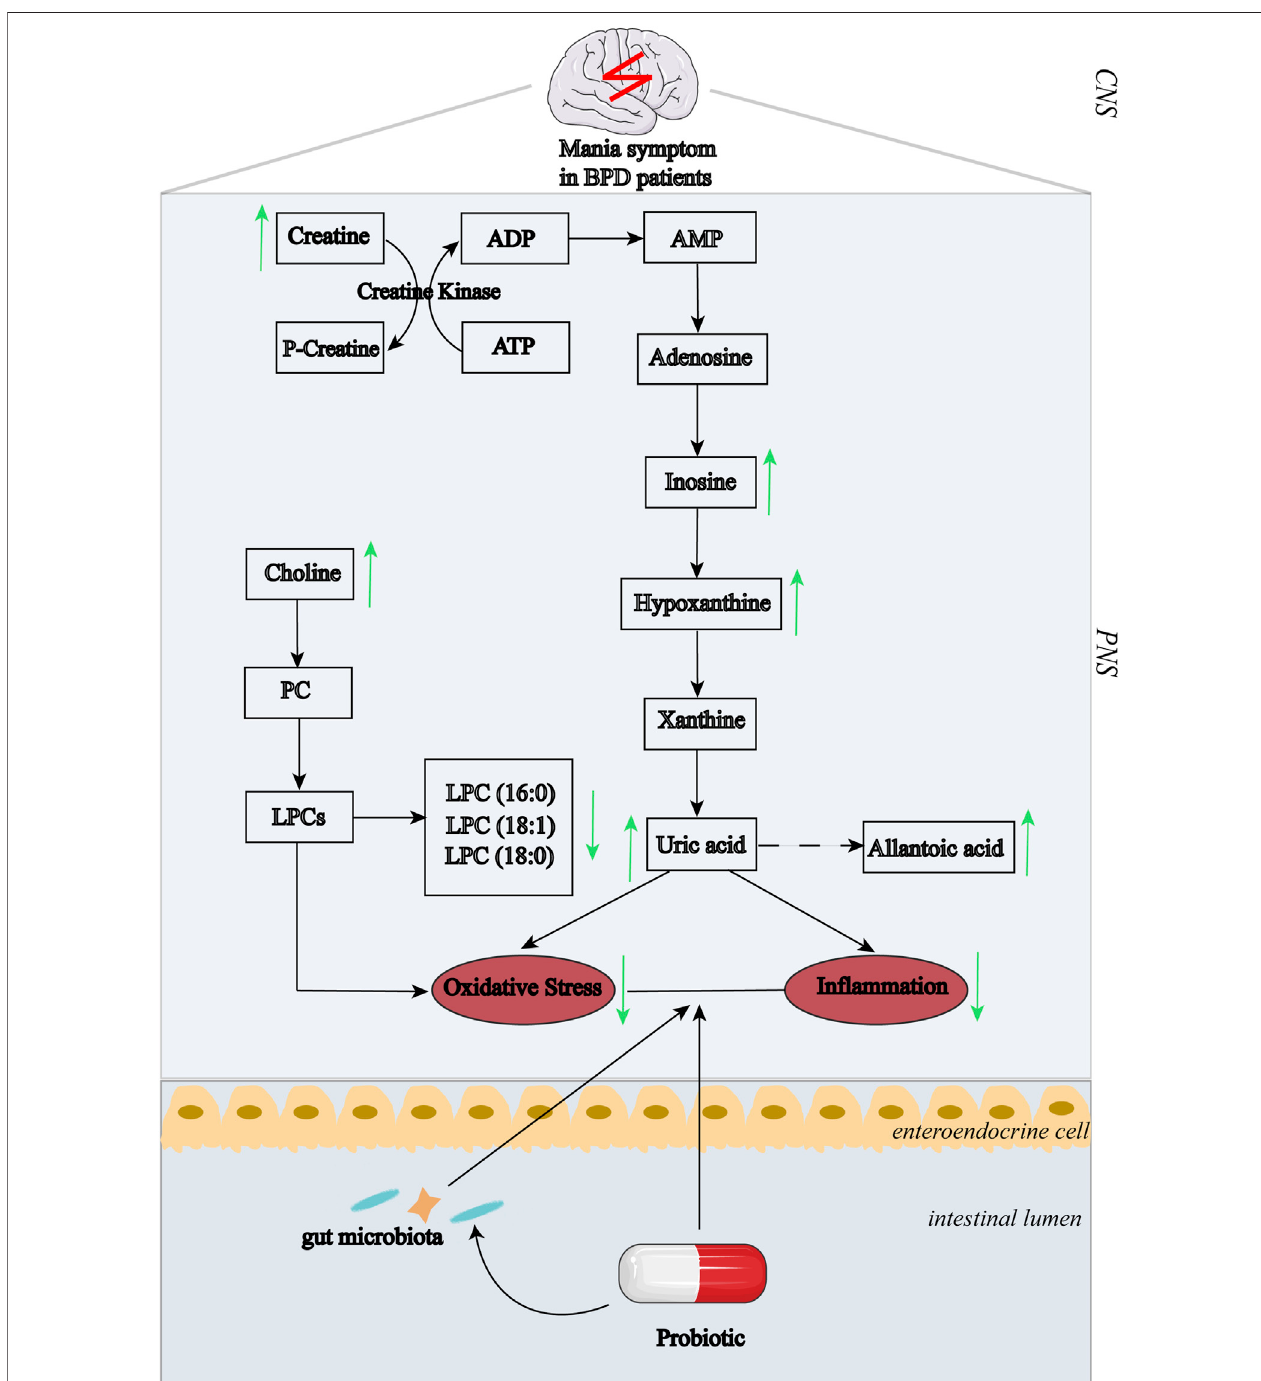
FIGURE 4 | Summary of the associations between pathways of purinergic metabolism and BPD symptoms after probiotic treatment. The changing trend in response to treatment: ↑ , increase; ↓ , decrease. Abbreviations: ADP, adenosine diphosphate; ATP, adenosine triphosphate; AMP, adenosine monophosphate; PC, phosphatidylcholine; LPCs, lysophosphatidylcholines; CNS, central nervous system; PNS, peripheral nervous system.